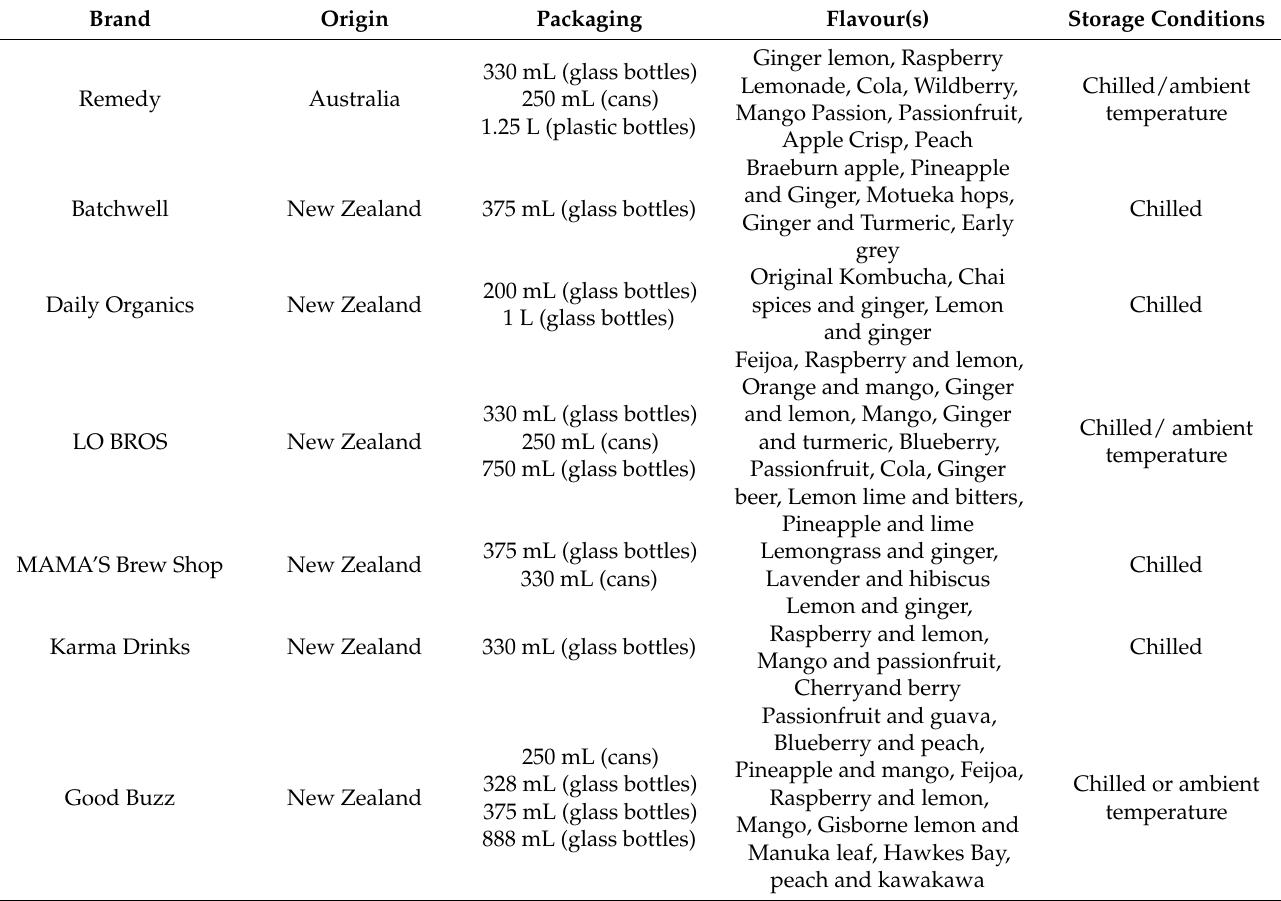
Table 1. Commercial Kombucha products sold in New